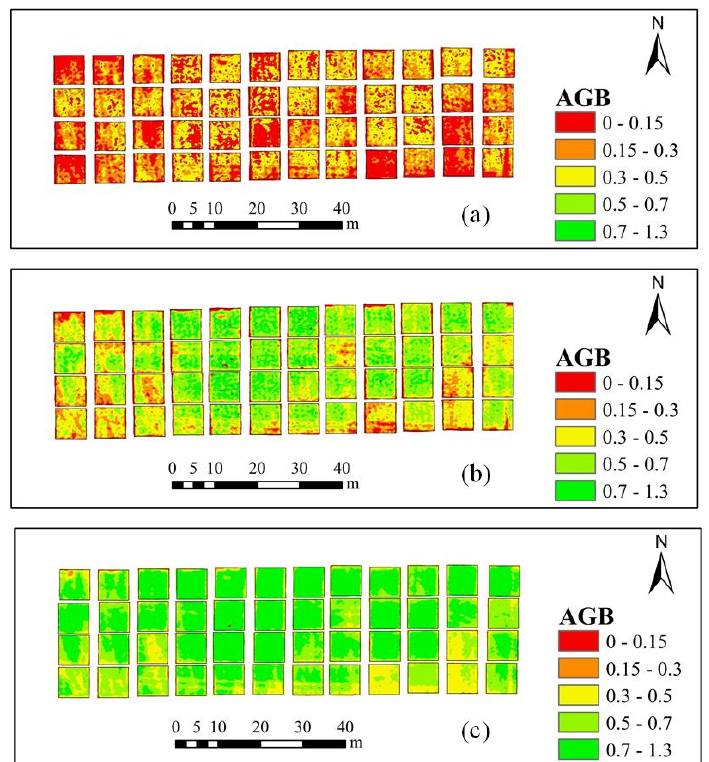
Figure 7. Maps showing the distribution of the estimated values of AGB (kg/m 2 ) in the 48 study plots obtained using a combination of VIs and RPs and using the PLSR method. ( a ) jointing stage; ( b ) flagging stage; ( c ) flowering stage.